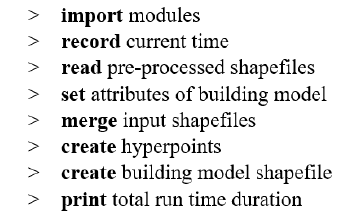
Figure 8. Pseudocode for the Python Script that Generates the Solar Irradiation